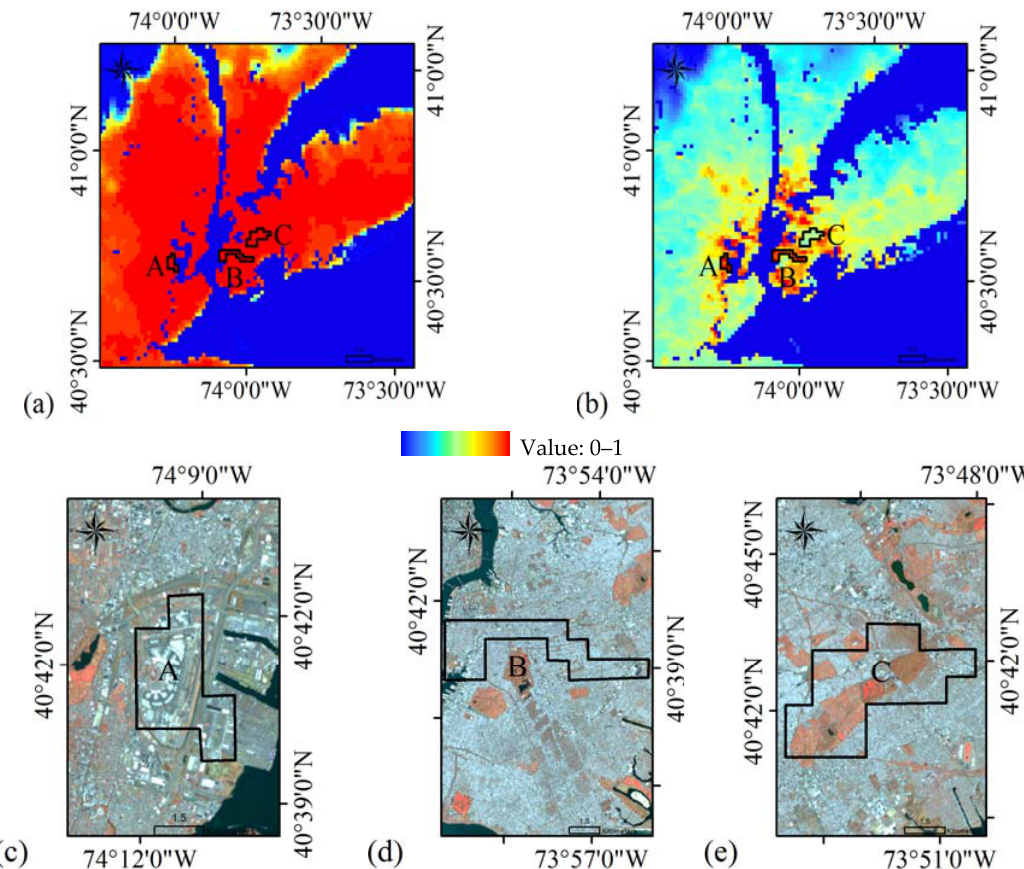
Figure 2. Raw NTL image ( a ) and LERNCI result ( b ) of New York and corresponding Landsat 8 with black boundary polygons. ( c ): A, Newark airport; ( d ): B, Brooklyn central blocks; ( e ): C, combination of High Land Park, the St John Cemetery and the Lutheran All Faiths Cemetery.